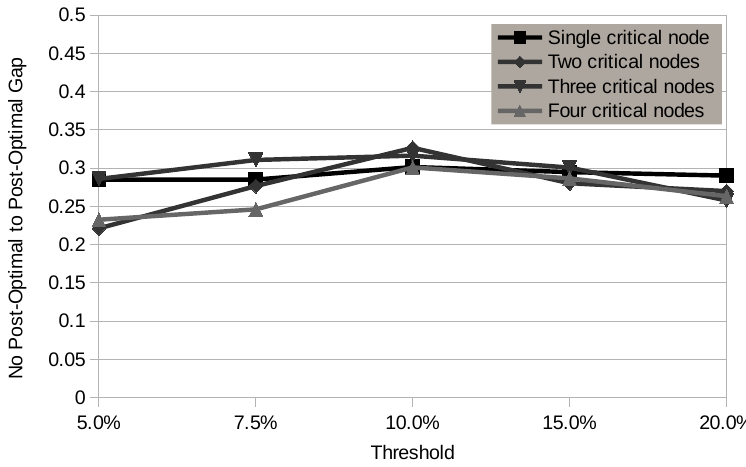
Figure 11. Decrease on distance values, obtained by the heuristic, when local search procedures are applied. Backup is being